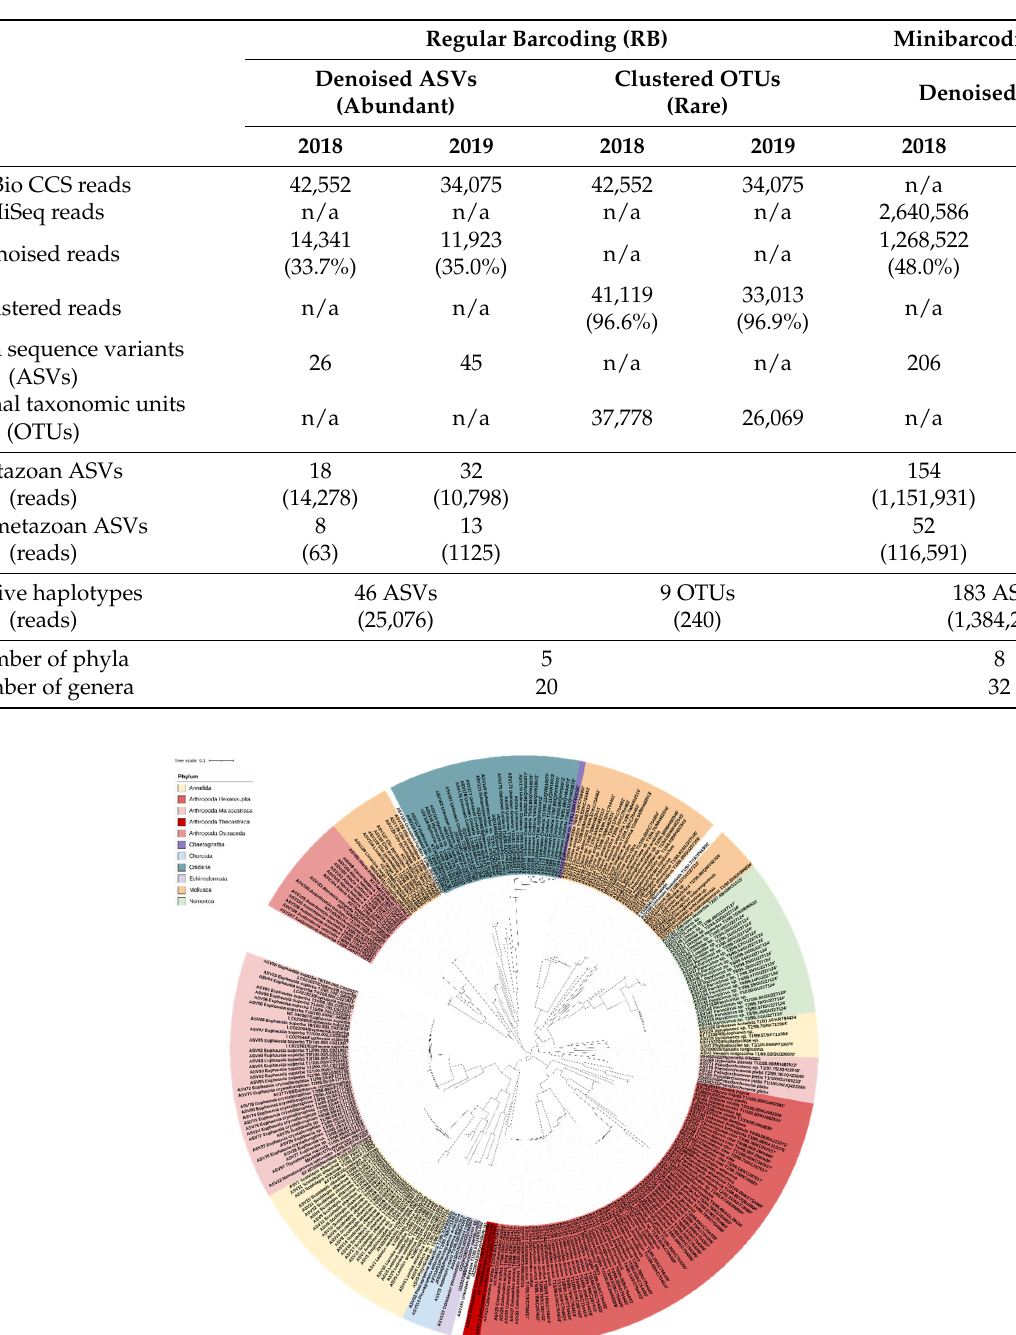
Table 1. Summary of two metabarcoding reads.